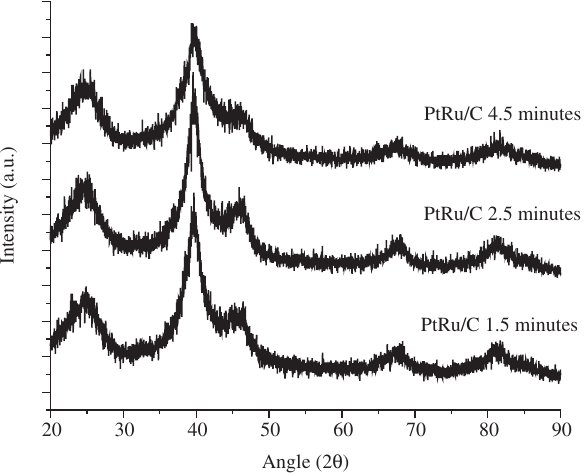
Figure 1. X ray diffractograms of PtRu/C electrocatalysts prepared using electron beam